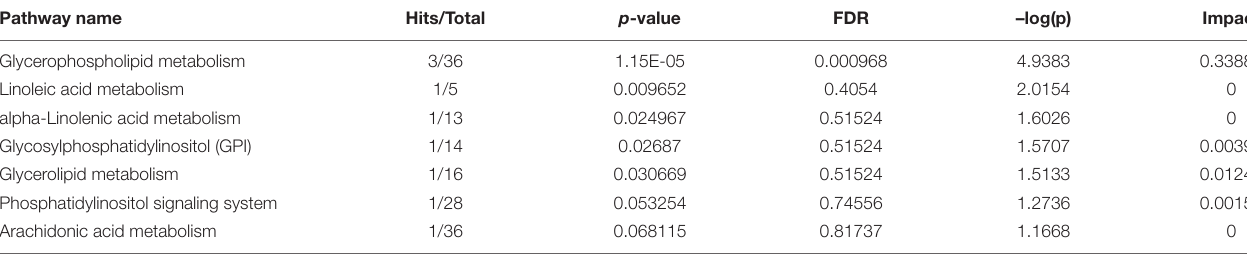
TABLE 5 | The main metabolic pathways of biomarkers.